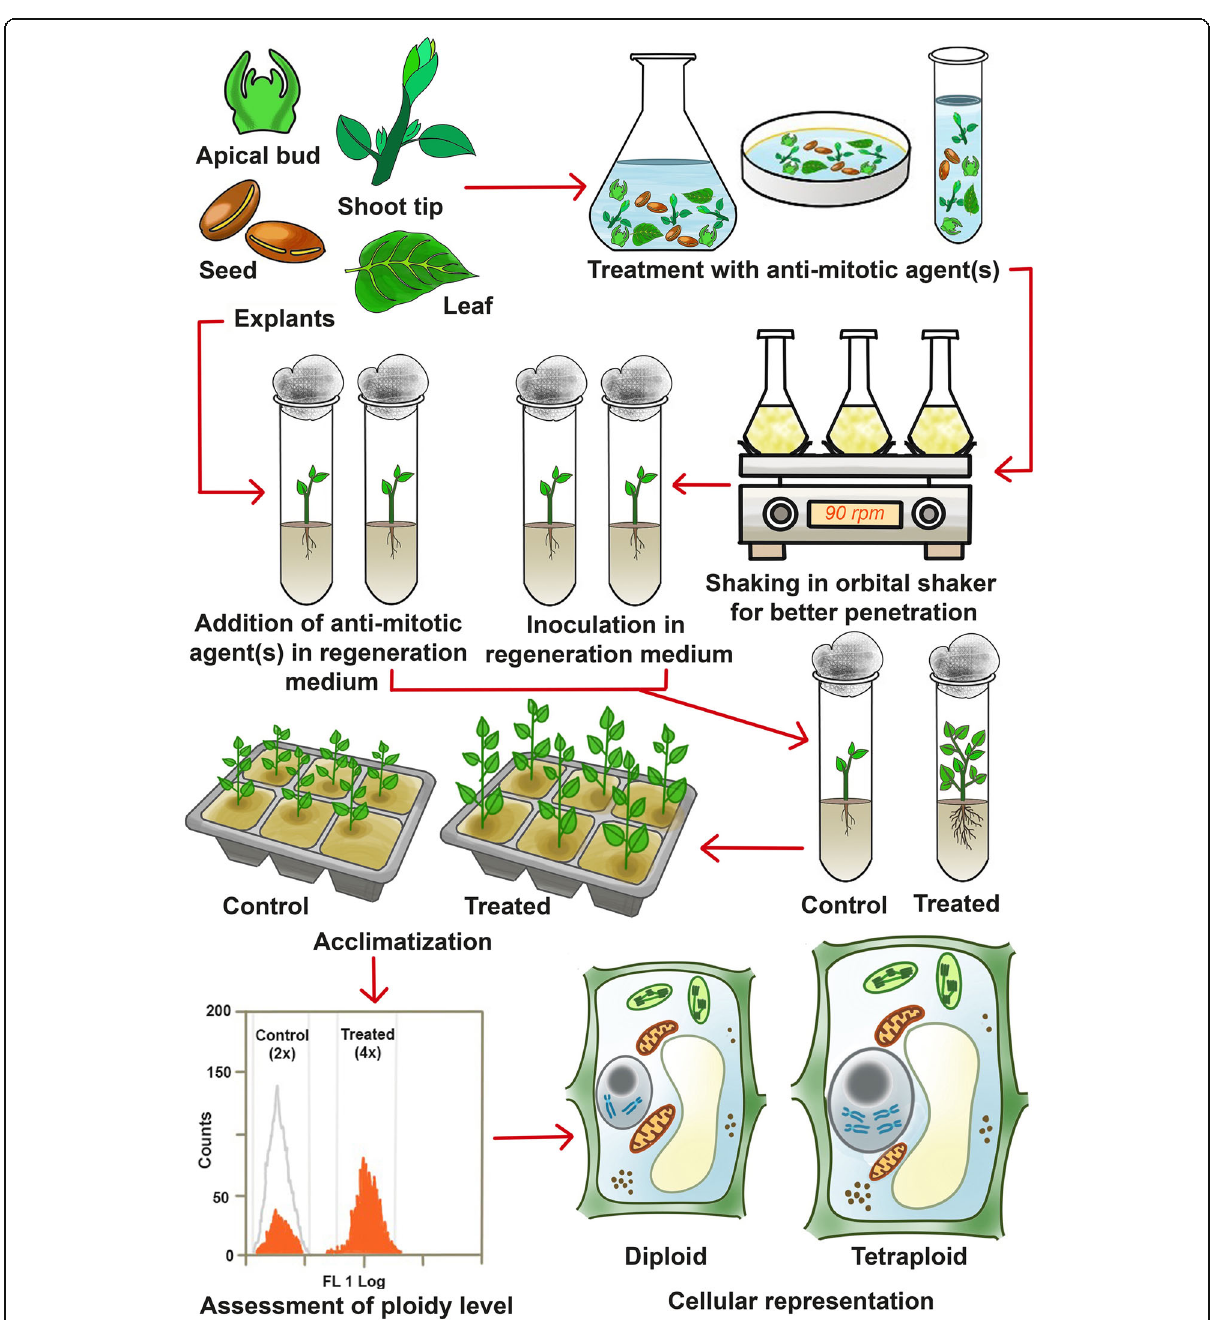
Fig. 1 Diagrammatic representation of in vitro induction of autopolyploidization (diagram is not in scale) (Source: unpublished diagram of Saikat